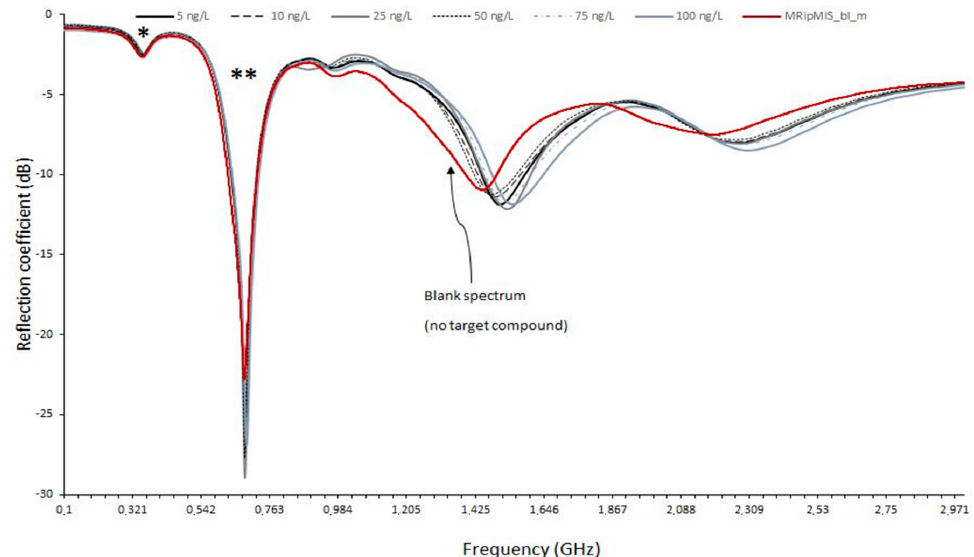
Figure 5. Detection of iprodione in a white wine sample using the microwave sensor coupled to MIS. Representative average microwave spectra. Added iprodione concentrations varied from 5 to 250 ng L − 1 . The two major bands (which contribute mostly to the model) are symbolized by * and **. The red spectrum corresponds to the white wine without any iprodione